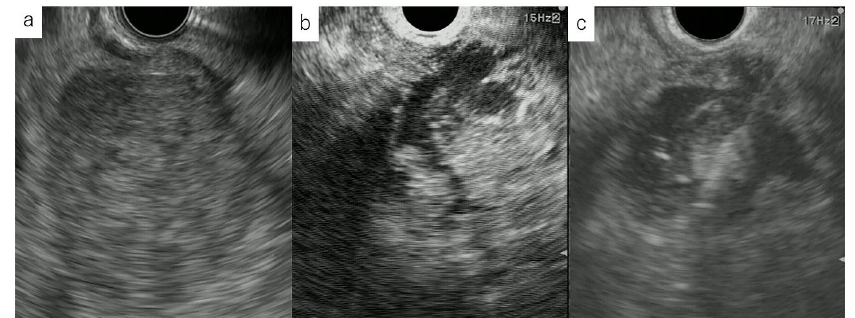
Figure 1. Targeting EUS-FNA with CH-EUS. ( a ) Fundamental B mode endoscopic ultrasonogram showing a low echoic mass. ( b ) CH-EUS image showing a non-enhancing area within the tumor. ( c ) EUS-FNA with CH-EUS avoiding the non-enhancing area.